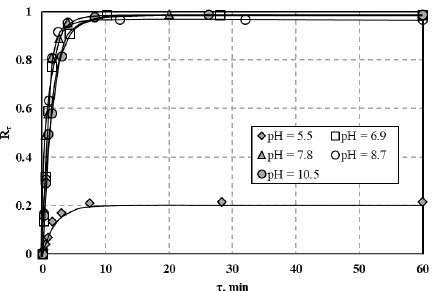
Figure A11. Changes in Cu(II) temporary removal ratio during ion and precipitate flotation from solution containing Al(III), Cu(II), and Zn(II) mixture—effect of pH (c 0 = 2 mmol dm − 3 , c SDS = 0.187, u G = 1.51 mm s − 1 ).